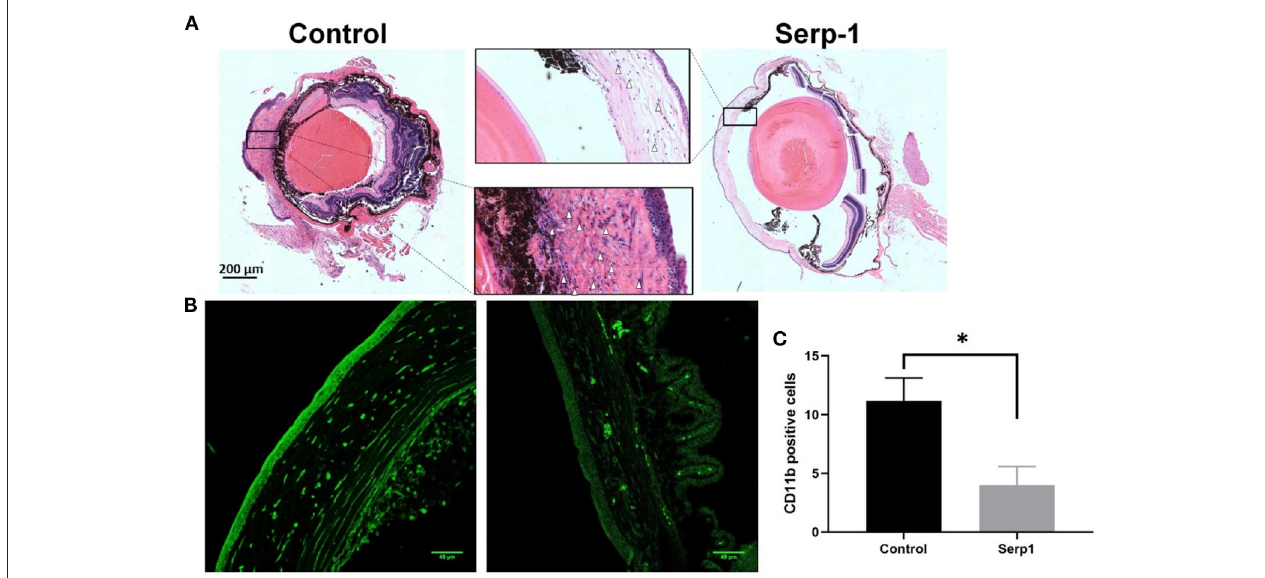
FIGURE 3 | Histochemical analysis of eye cross-sections show reduced rates of inflammatory cell infiltration and swelling of the cornea in Serp-1 treated mice. (A) Histochemical analysis of eye cross-sections shows reduced rates of inflammatory cell infiltration and swelling of the cornea in Serp-1 treated mice. Enlarged images of the corneal region of two mice visibly show more swelling and a higher presence of inflammatory cells in the control mice. Inflammatory cell nuclei are stained by the deep-purple spots marked with white triangles in the light pink stromal layer of the cornea. (B) To further identify infiltrating immune cells, the slides were stained with